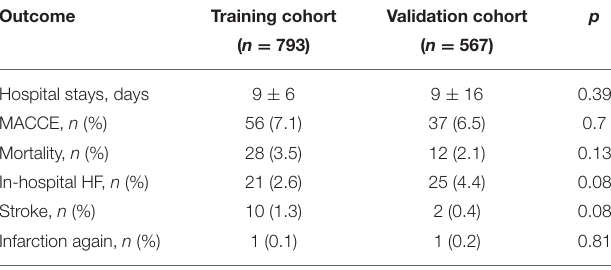
TABLE 2 | Outcome of ACS Patients in training cohort and validation cohort.